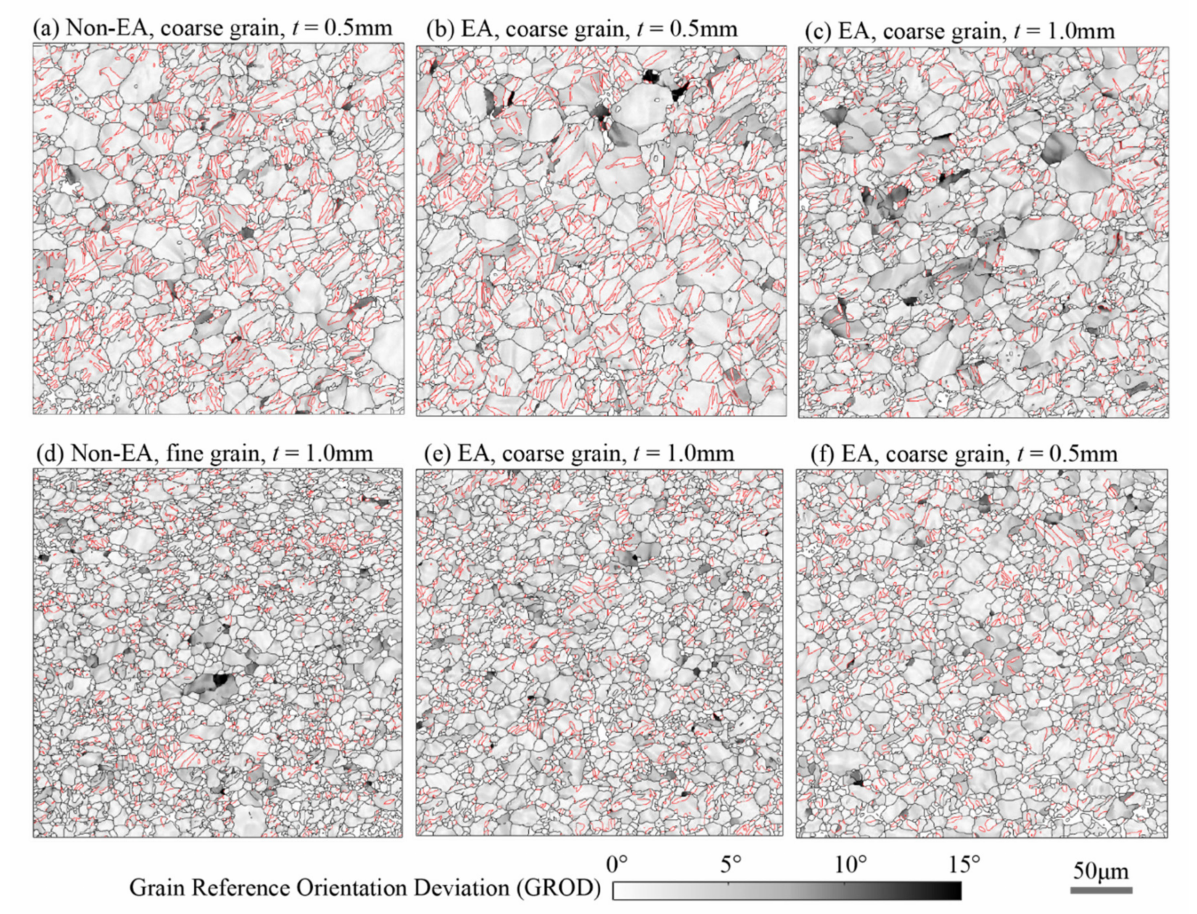
Figure 7. Grain reference orientation deviation (GROD) overlaid with grain boundaries (black lines) and extension twin boundaries (red lines) of the samples strained to 10% tensile